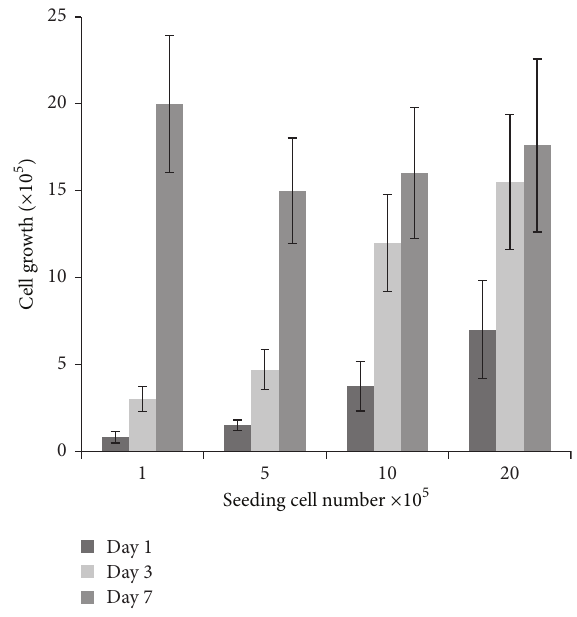
Figure 6: Cell proliferation measured at day 1 (dark grey), day 3 (light grey), and day 7 (grey) by MTT assay with different seeding numbers for 1-2 hours initial seeding time. The data are generated on three individual experiments with triplicate, normalised with standard